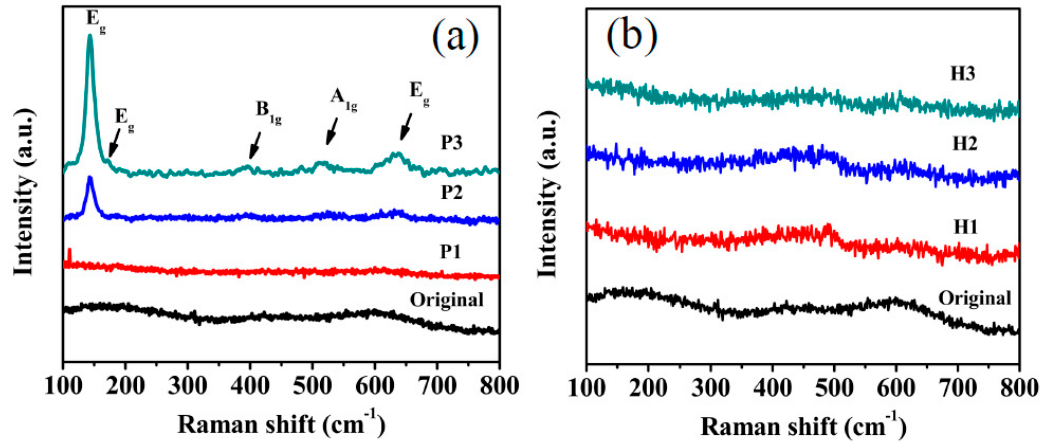
Figure 6. Raman shift spectra of ( a ) plasma treated at different power, ( b ) heating treated at different temperature.